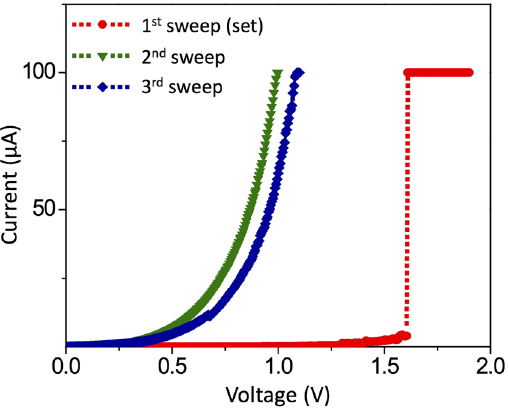
Figure 5. I-V graphs for a set process (compliance current = 100 μ A) and followed by potentiodynamic sweeps through a scanning probe-based Pt/TiO 2 /Au cell. The Pt/TiO 2 tip was electroformed on a Pt substrate prior to these